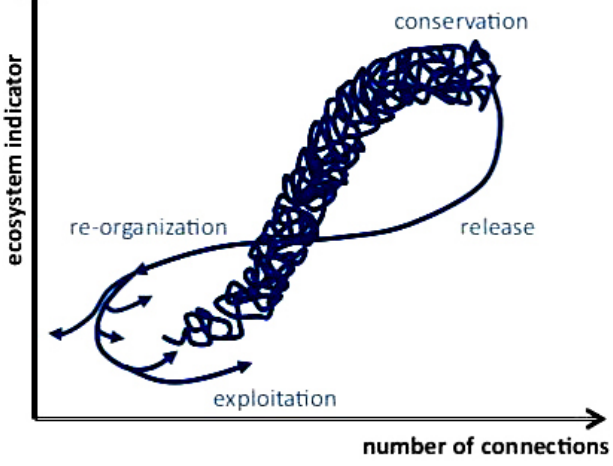
Fig. 2. Adaptive cycle as modified by Burkhard et al. (2011).